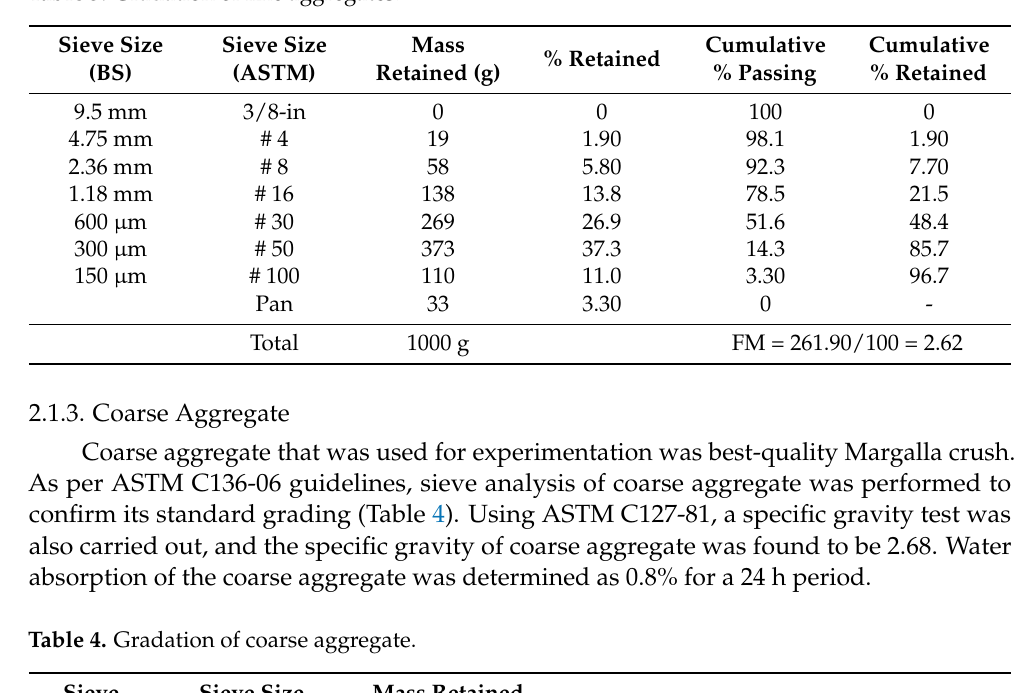
Table 3. Gradation of fine